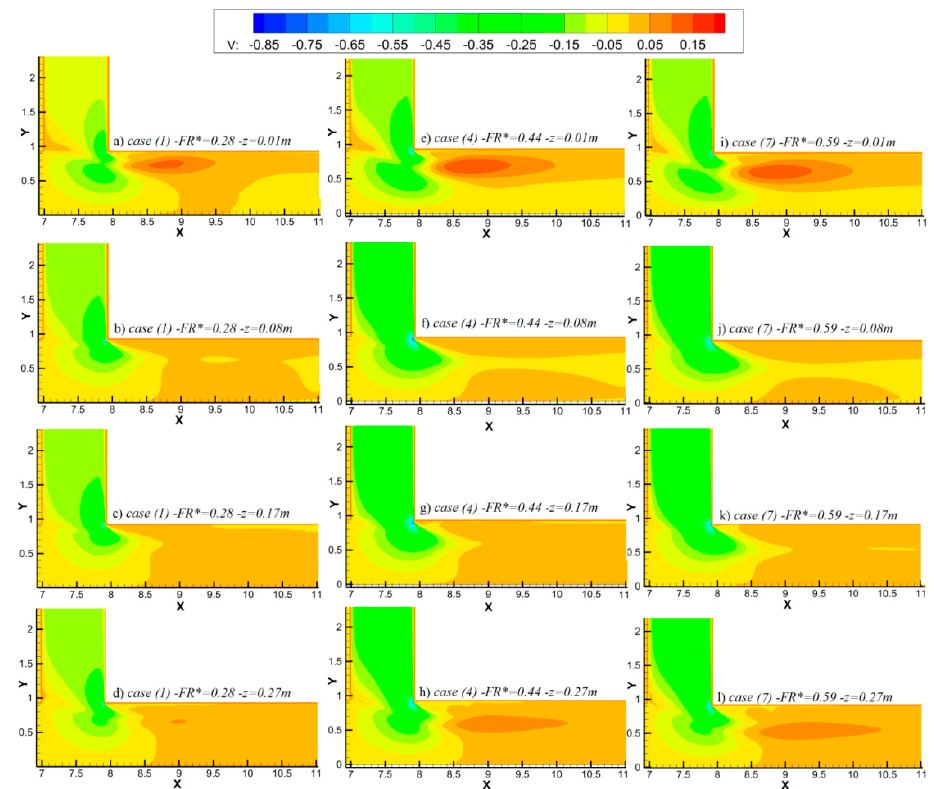
Figure 4. The distribution of the stream-wise component of velocity (U) for ( a – d ) case 1, and ( e – h ) case 4, and ( i – l ) case 7.